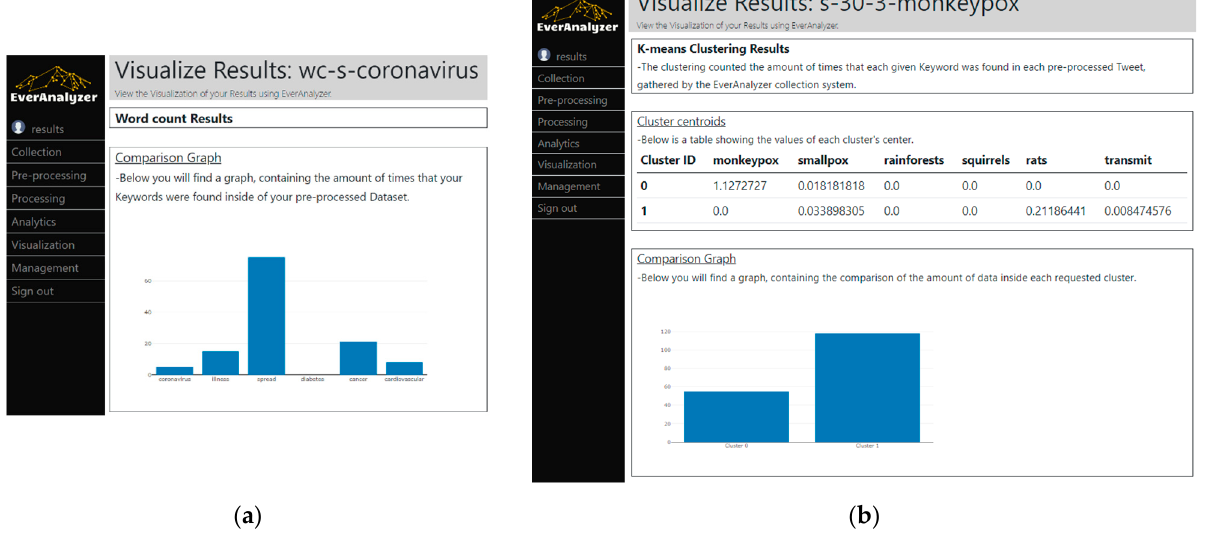
Figure 22. ( a ) Visualization of processing task; ( b ) Visualization of analysis task.